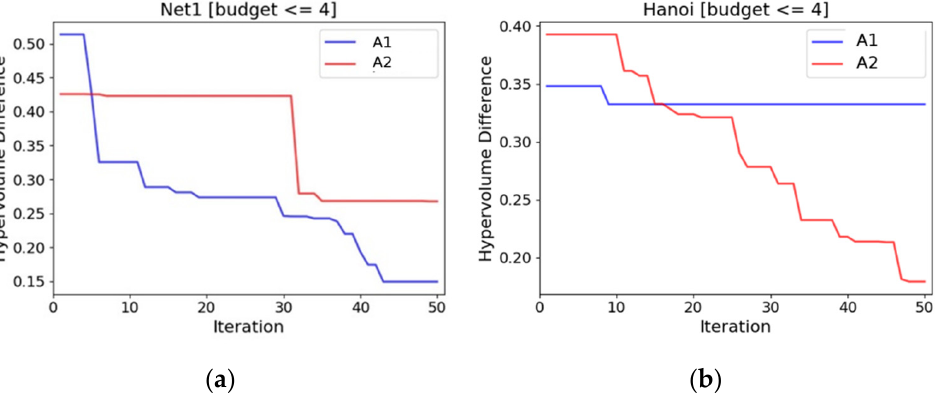
Figure 7. Difference in hypervolume between the optimal Pareto front and the Pareto front approximated by A1 (blue) and A2 (red) over the iteration considering Net1 ( a ) and Hanoi ( b ). It is apparent that A2’s relative performance improved with the size of the problem.